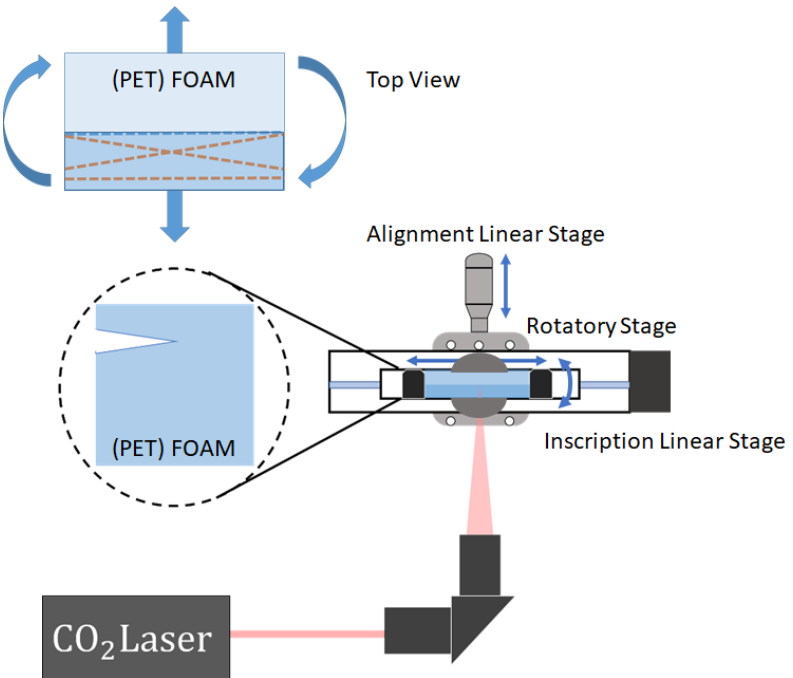
Figure 3. Experimental setup used for the alignment of the CO 2 laser on the motor travel axis. The focal point could be continuously monitored during the entire travel of the